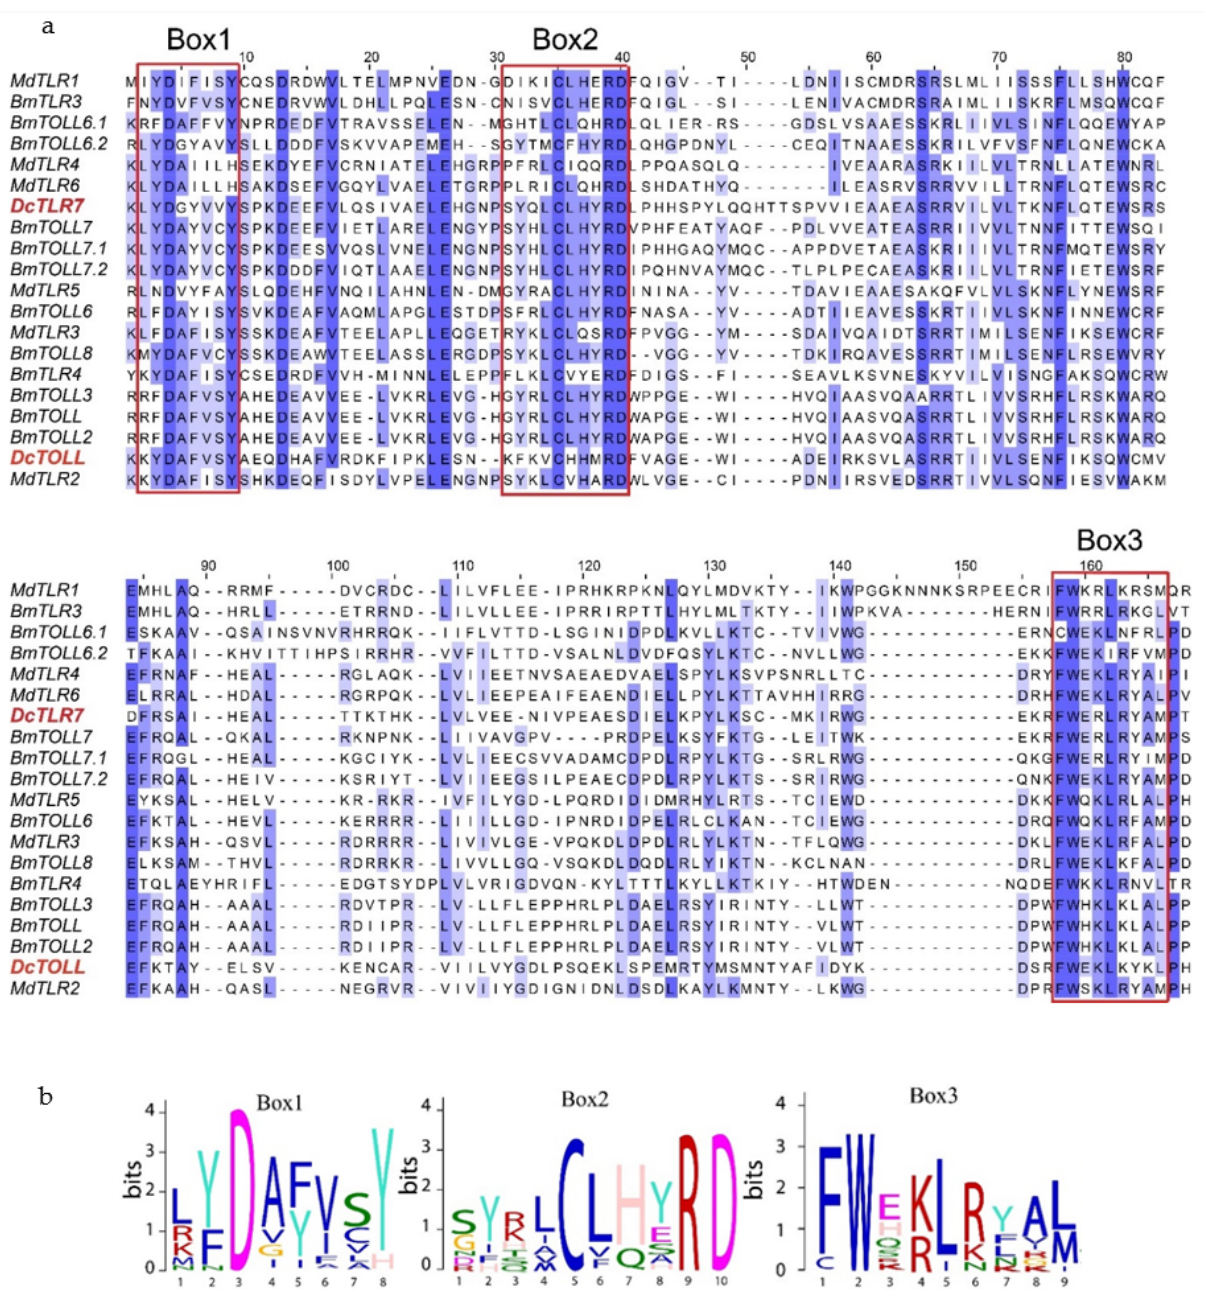
Figure 4. ( a ) Sequence alignment of TIR domains from Diaphorina citri , Bombyx mori and Musca do- mestica ; sequences in a red square are Box 1, 2 and 3, respectively. ( b ) Sequence logos of Box 1, 2 and domestica ; sequences in a red square are Box1, 2 and 3, respectively. ( b ) Sequence logos of Box1, 2 and 3 from the sequence alignment. 3 from the sequence